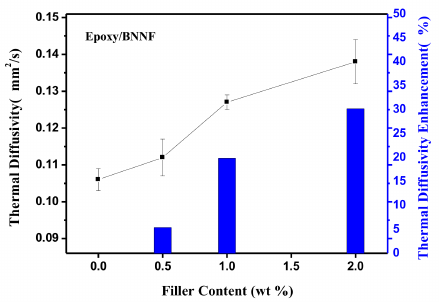
Figure 5. The thermal diffusivity and enhancement of four samples with different mass fraction of